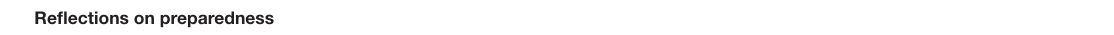
TABLE 4b | Trial decision-making and